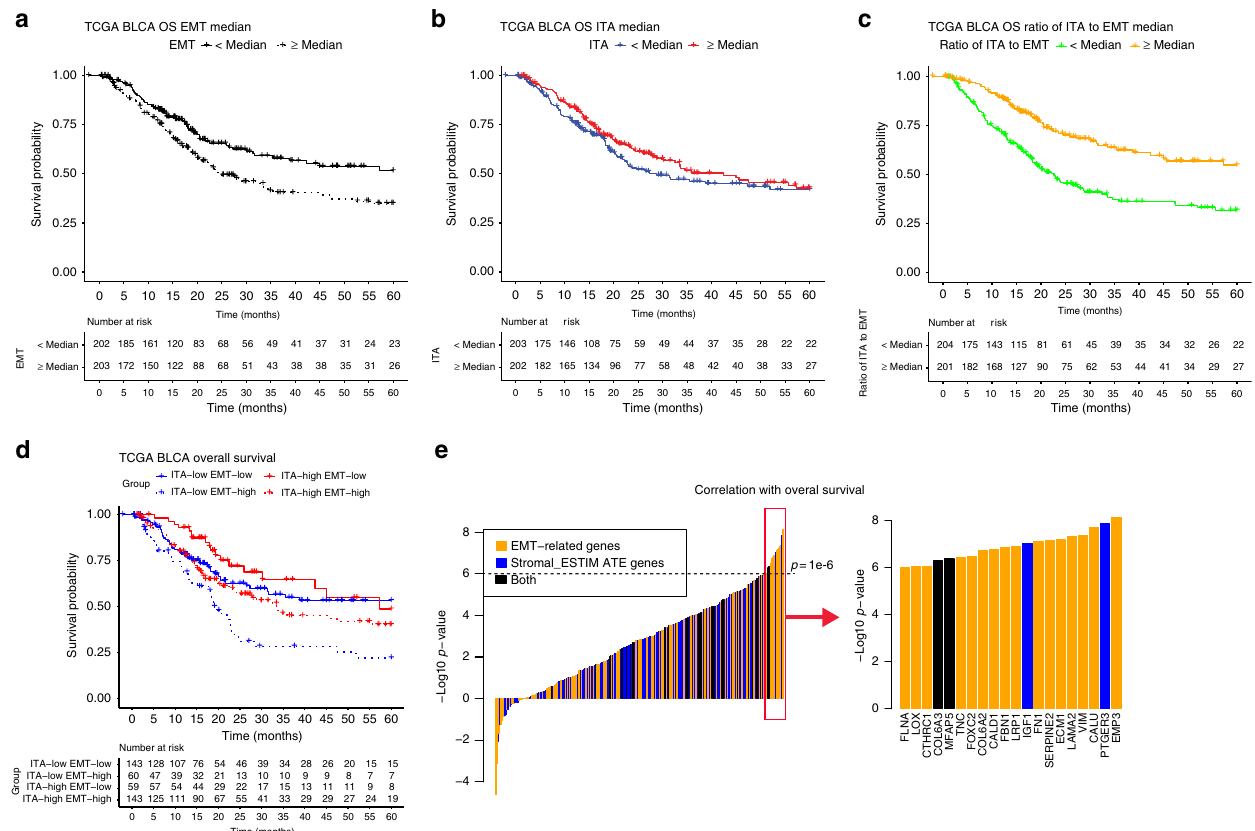
Fig. 4 EMT-related gene expression and T-cell related gene expression confer disparate prognostic information in patients with muscle-invasive UC of the bladder treated with cystectomy. Kaplan – Meier survival curves for UC patients in TCGA ( n = 405) divided into two groups by the a EMT-related gene expression, b ITA gene expression, c the ratio of ITA to EMT, or d divided into four groups by both EMT-related and ITA gene expression. Median EMT and ITA values were used to distinguish low vs. high expression. e Individual EMT-related and stromal_ESTIMATE genes were ranked according to the signi fi cance of their association with survival. Y -axis shows the − log10 p -value by the Wald test for each individual gene in the bivariate cox-regression model where ITA was included (those associated with worse survival were assigned log10 p -value